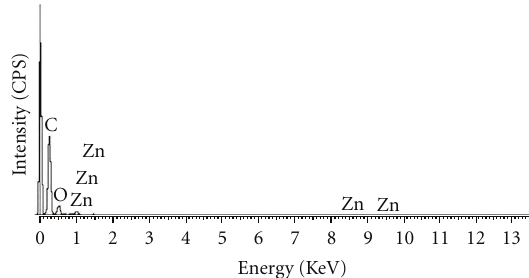
Figure 2: EDX results for ZnO thin films deposited on PET